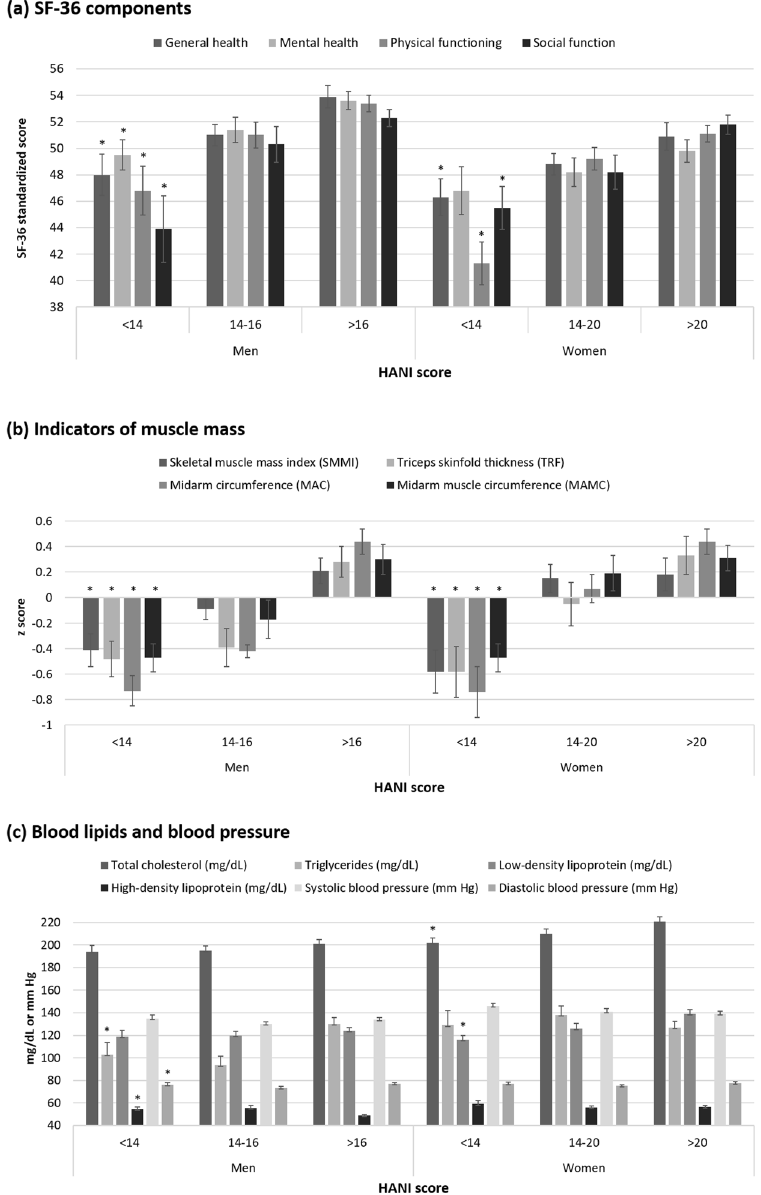
Figure 2. Mean of SF-36 components ( a ), indicators of muscle mass ( b ) and ( c ) blood lipids as well as blood pressure between HANI groups by gender in the validation set. P values were examined by ANOVA. * P value less than 0.05 between HANI groups in men and women, respectively. HANI, Healthy Ageing Nutrition Index; SF-36, Short